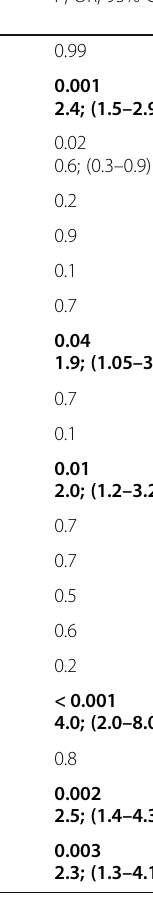
Table 6 Probable risk factors in patients with sentinel headache compare to the patients without sentinel headache during one year before stroke Patients with sentinel headache before stroke ( n =